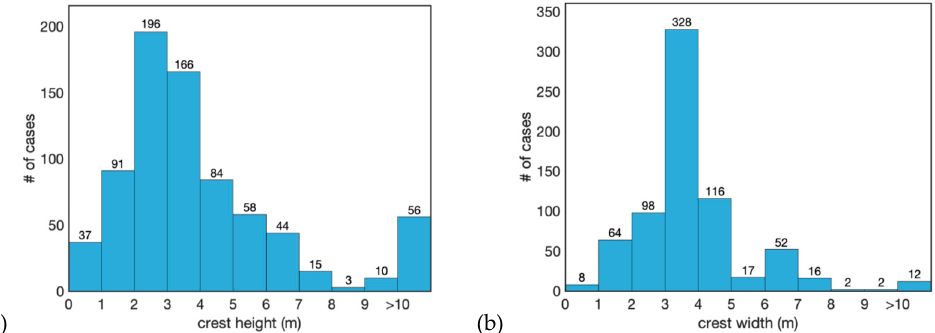
Figure 5. Statistics of the levee information ( a ) crest height, ( b ) crest width (m) per number of cases.